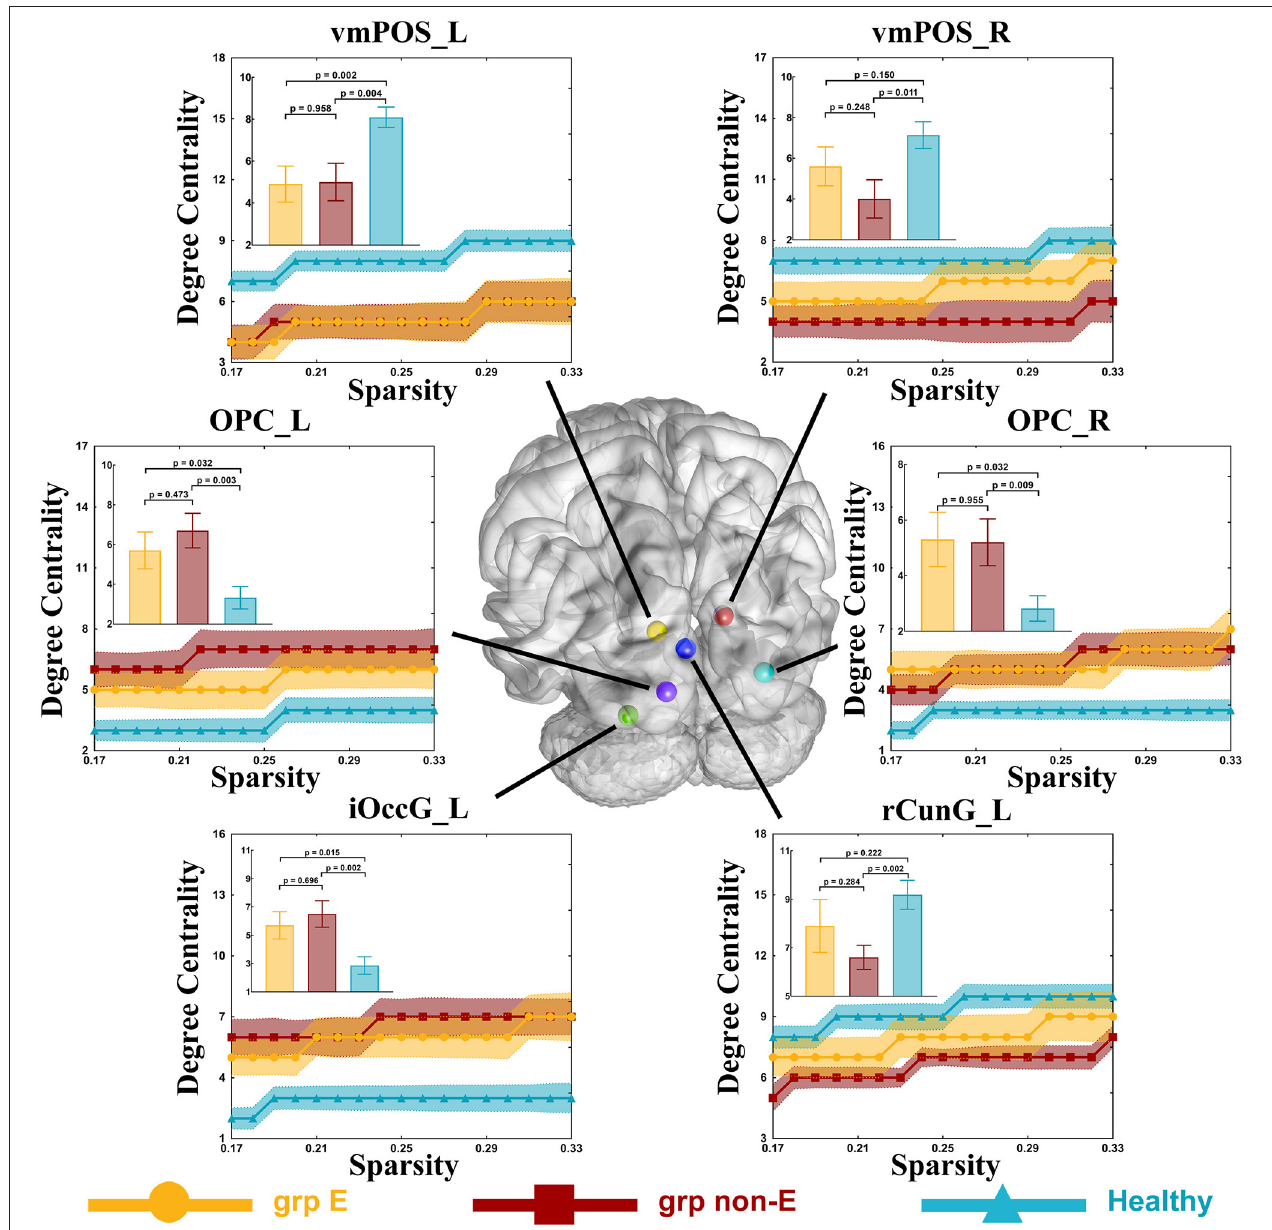
FIGURE 4 | Significant alterations in degree centrality. Grp E = GRE group. P -value threshold after FDR correction is 0.011. Grp non-E = non-GRE